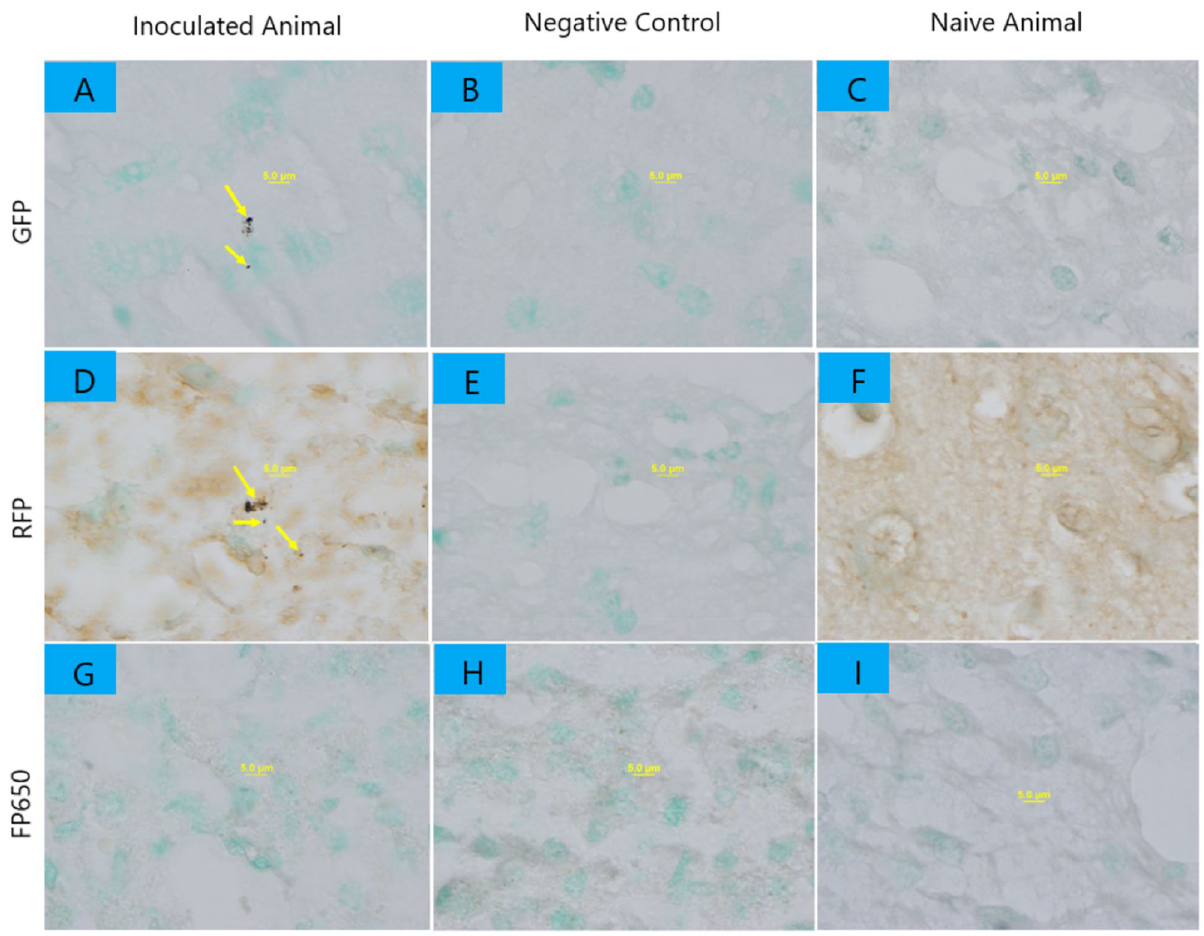
Figure 1. Bacteria fluorescent protein IHC staining with DAB reporter (dark brown) of fetal cerebral cortex. ×100 magnification. ( A ) Inoculated animal, GFP immunohistochemical labeling of bacteria (yellow arrows); ( B ) negative control, immunohistochemical labeling without primary (anti-GFP) antibody. ( C ) Naïve animal, GFP immunohistochemical labeling as in ( A ); ( D ) inoculated animal, RFP immunohistochemical labeling of bacteria (yellow arrows); ( E ) negative control, immunohistochemical labeling without primary (anti-RFP) antibody. ( F ) Naïve animal, RFP immunohistochemical labeling of bacteria. ( G ) Inoculated animal, FP650 immunohistochemical labeling of bacteria; ( H ) Negative control, immunohistochemical labeling without primary (anti-FP650) antibody. ( I ) Naïve animal, RFP immunohistochemical labeling of